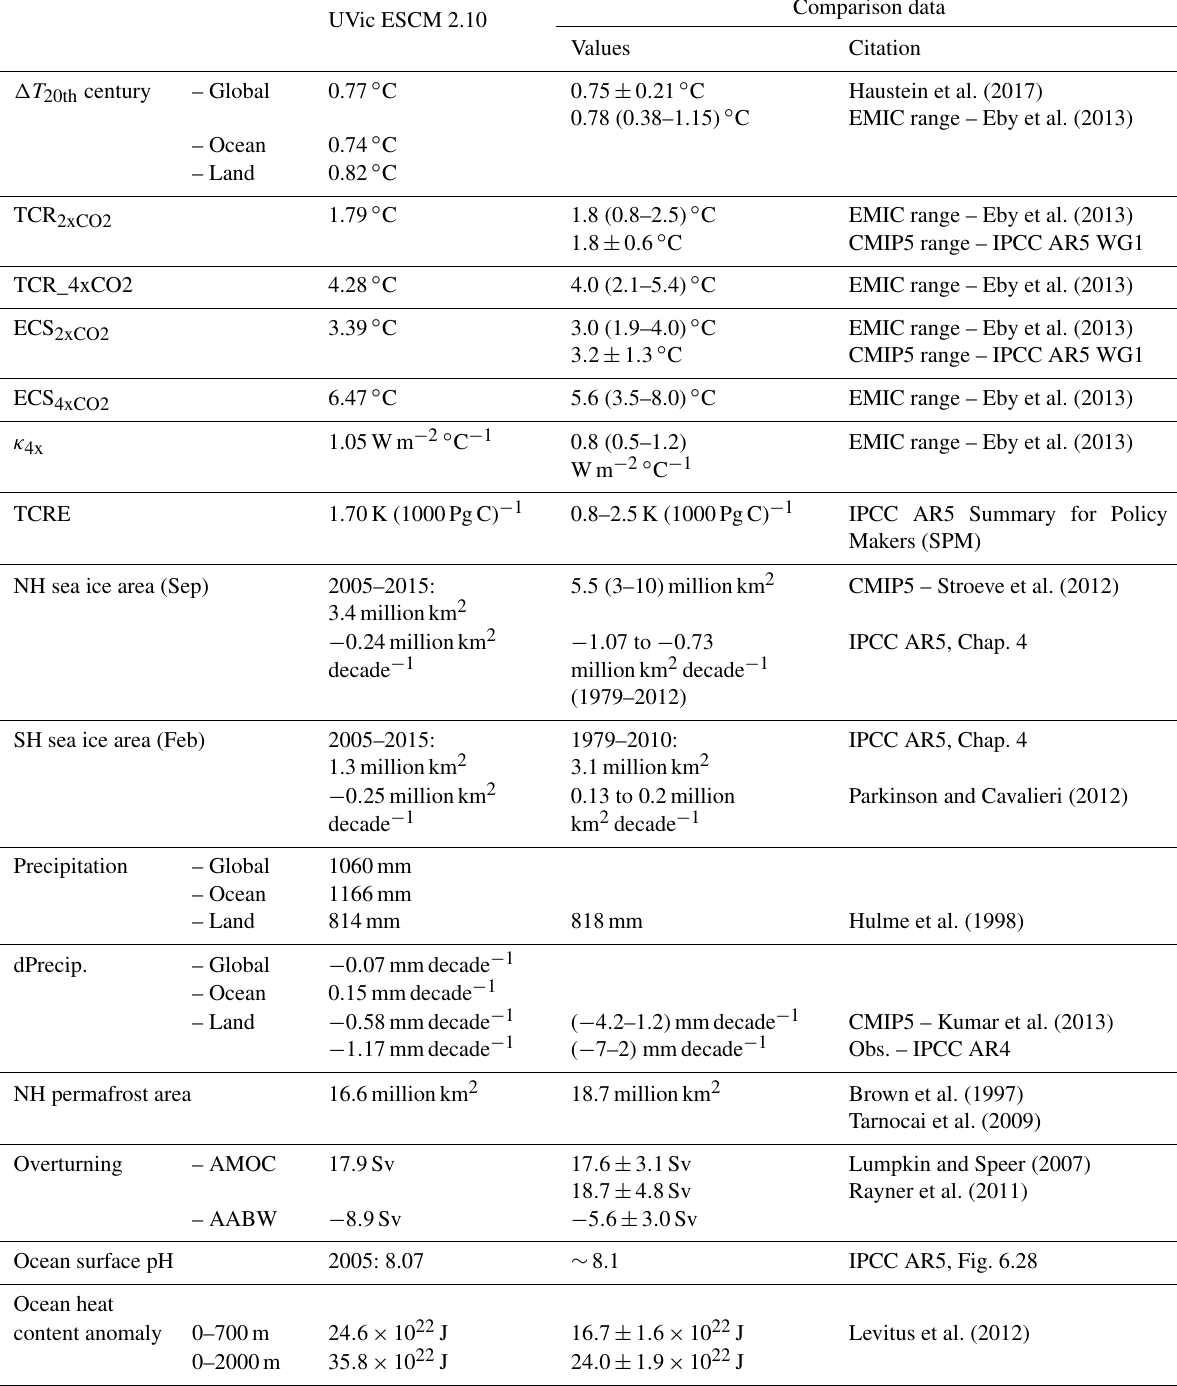
Table 1. Key global mean metrics of the UVic ESCM 2.10 compared to relevant observations or model intercomparison projects. The (cid:49)T 20th century is the change in surface air temperature over the 20th century from the historical “all” forcing experiment. TCR 2xCO2 , TCR_4xCO2 and ECS 4xCO2 are the changes in global average model surface air temperature from the decades centered at years 70, 140 and 995, respectively, from the idealized 1% increase to 4xCO2 experiment. The ocean heat uptake efficiency, κ 4x , is calculated from the global average heat flux divided by TCR_4xCO2 for the decade centered at year 140 from the same idealized experiment. Note that ECS 4xCO2 was calculated from the decade centered at year 995 from the idealized 1% increase to 2xCO2 experiment. UVic ESCM